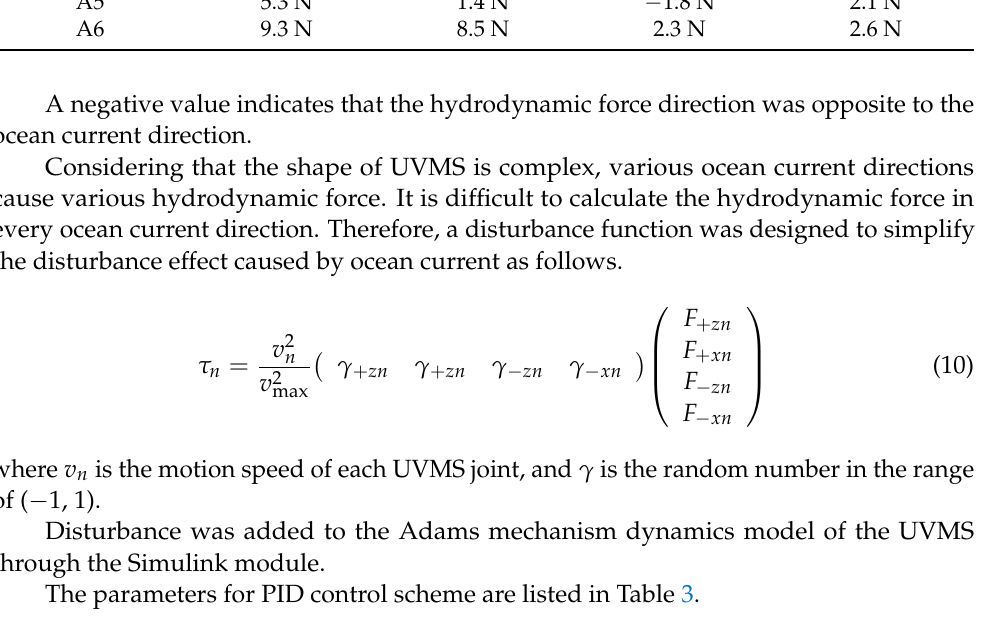
Table 2. Steady Hydrodynamic Force of Each UVMS Joint.